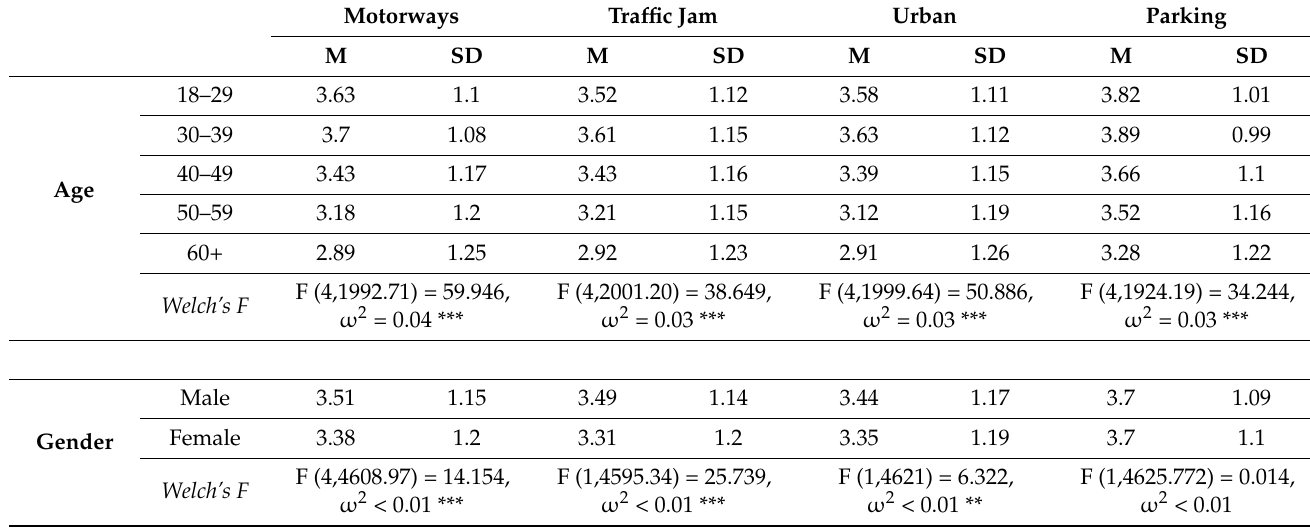
Table 5. Mean (M), standard deviation (SD), and ANOVA test results for intention to use different ADFs, by age group and gender.